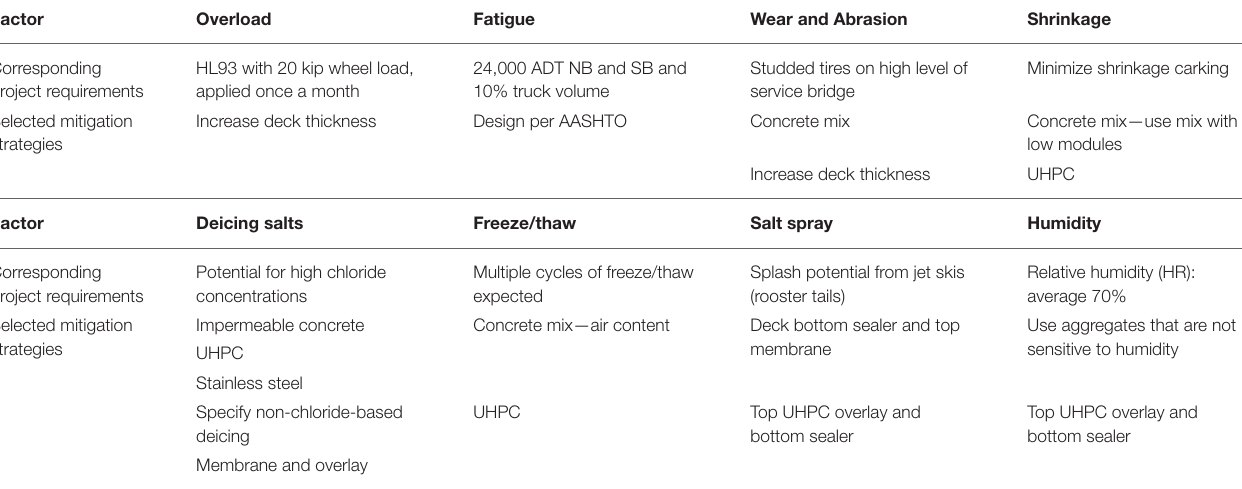
TABLE 3 | List of strategies specific for developing closure joint alternatives and options for service life design of the practical implementation